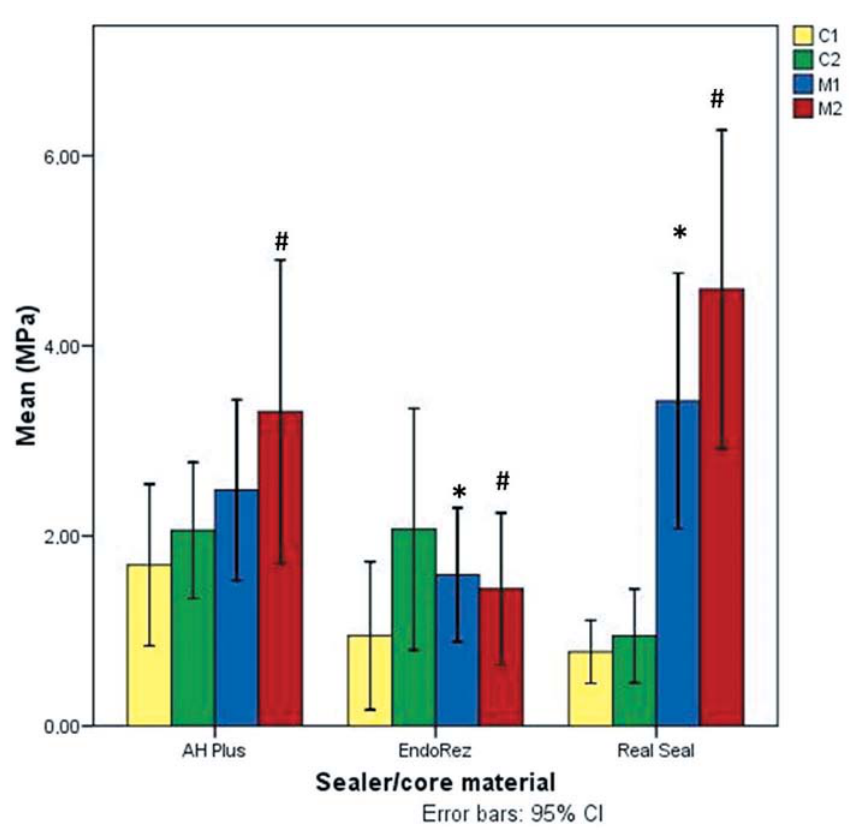
Figure 1- Bar chart showing μPush-out bond strength values and comparisons among sealer/core materials in each root level (Mann-Whitney's